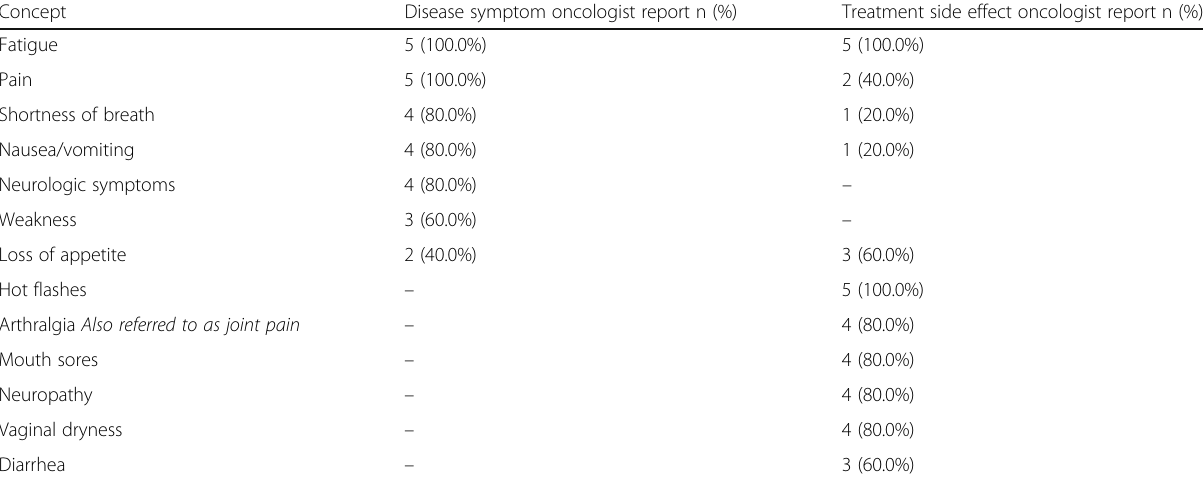
Table 5 Oncologist-reported HR+/HER2- advanced breast cancer concepts ( N = 5) Concept